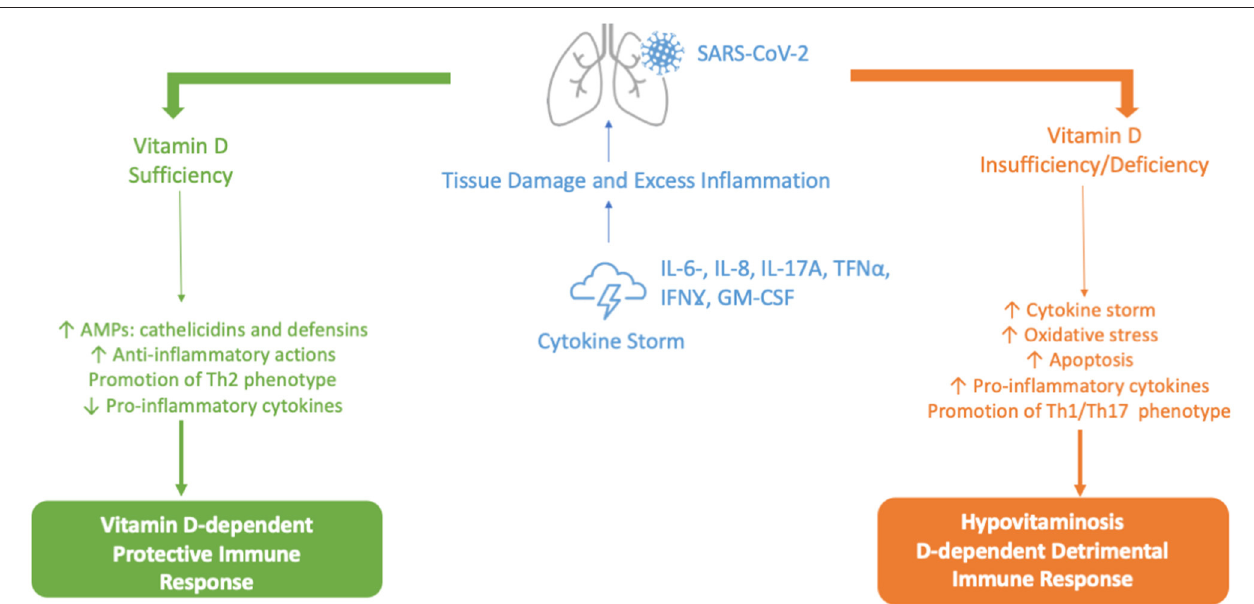
FIGURE 3 | Vitamin D-dependent Protective vs. Hypovitaminosis D-dependent Detrimental Immune Response against SARS-CoV-2. AMPs, antimicrobial peptides; GM-CSF, granulocyte-macrophage colony-stimulating factor; IL-6, IL-8, IL-17A, interleukin 6, 8 and 17A; IFN γ , interferon-gamma; Th1, Th2, Th17, type 1T helper